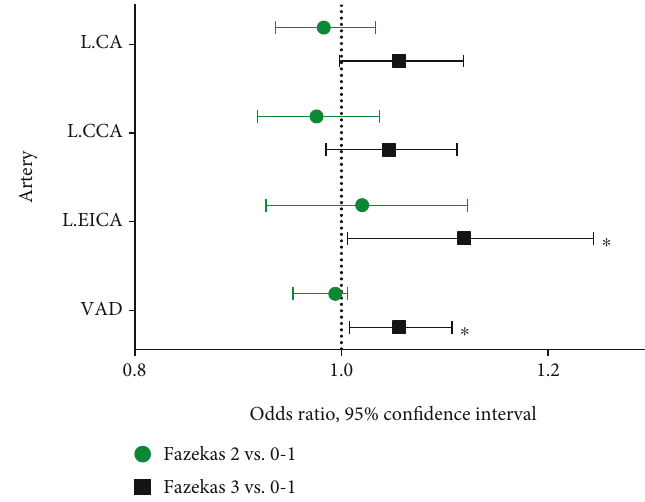
Figure 4: The arterial tortuosity by location in severity of WMHs in AIS patients. ∗ P < 0 : 05 and ∗∗ P < 0 : 01